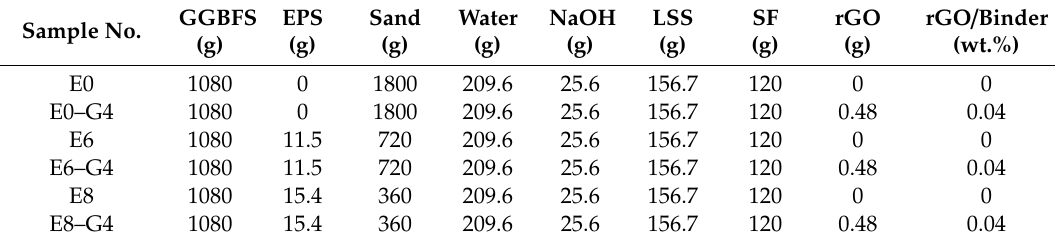
Table 4. Mixture proportions of alkali-activated slag mortar in this